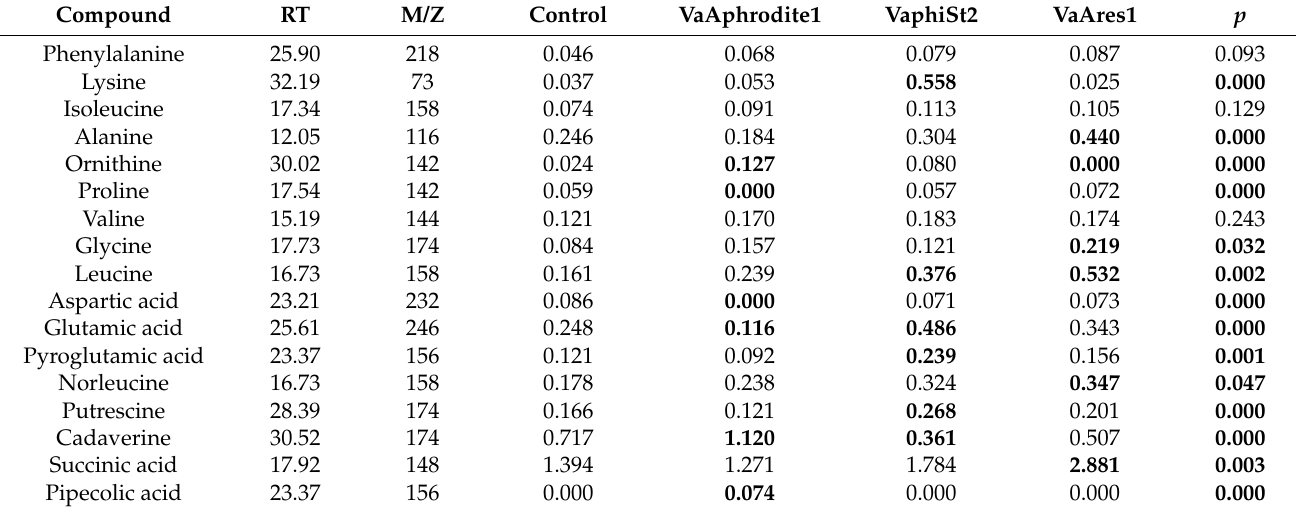
Putrescine 28.39